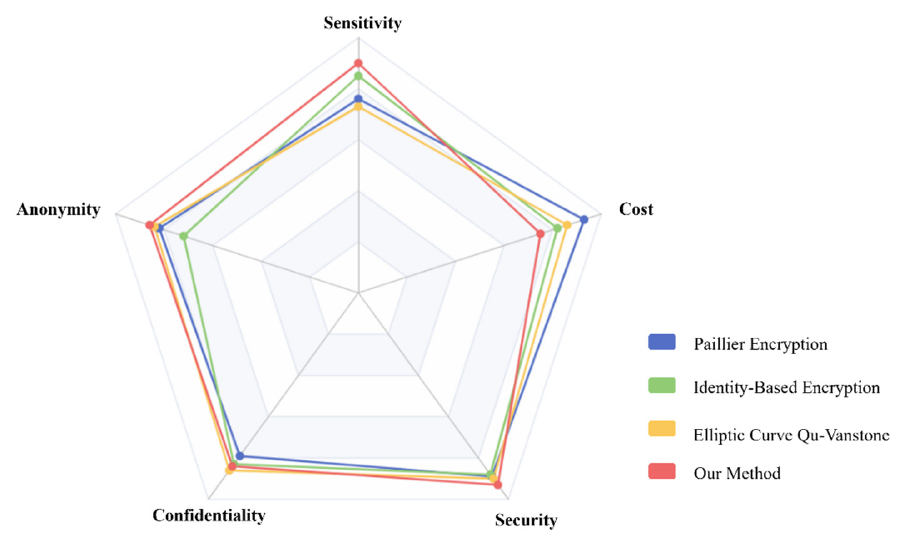
Figure 7. Comprehensive attribute comparison. The four colored polylines in Figure 7 represent four authentication scheme models.